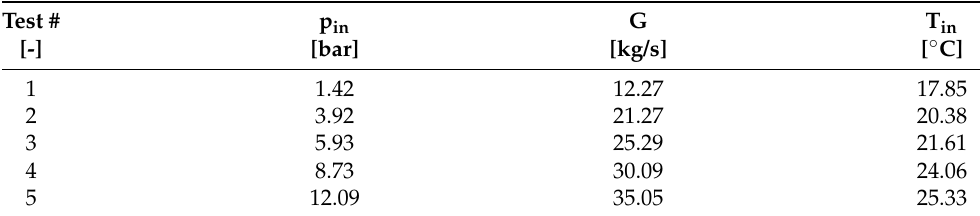
Table 4. List of selected experimental tests.